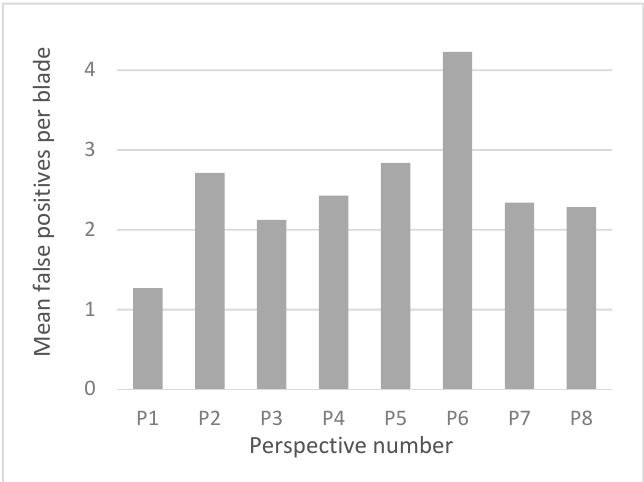
Figure 13. Average false positive rates for each perspective.